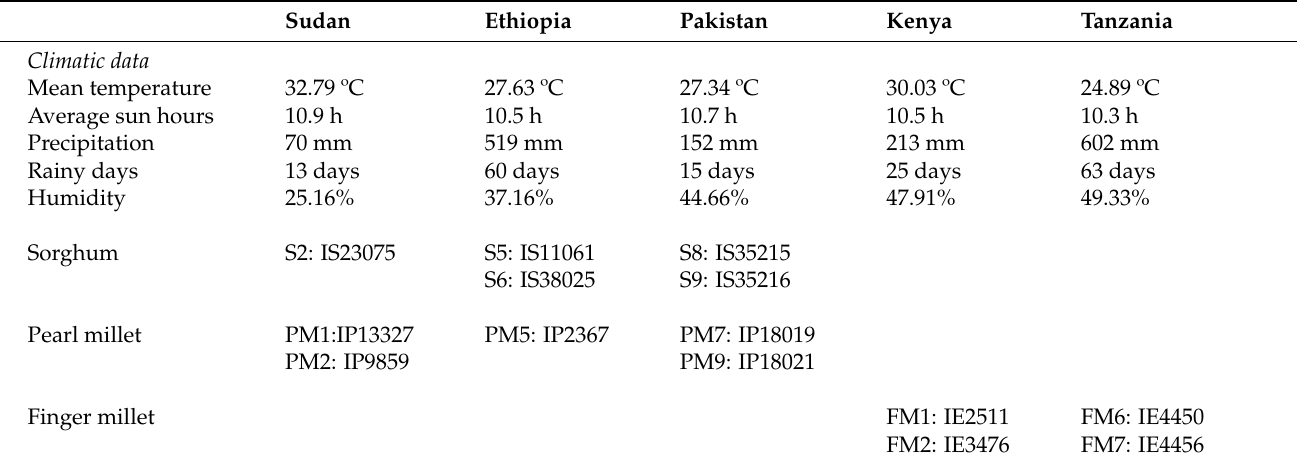
Table 3. Selected landraces from the ICRISAT genebank with a. the acronym used to identify them and b. their accession number. Climatic data are expressed as the annual mean. Precipitation and rainy days represent the total annual condition. Climatic indices are specific to the region of interest from which the samples